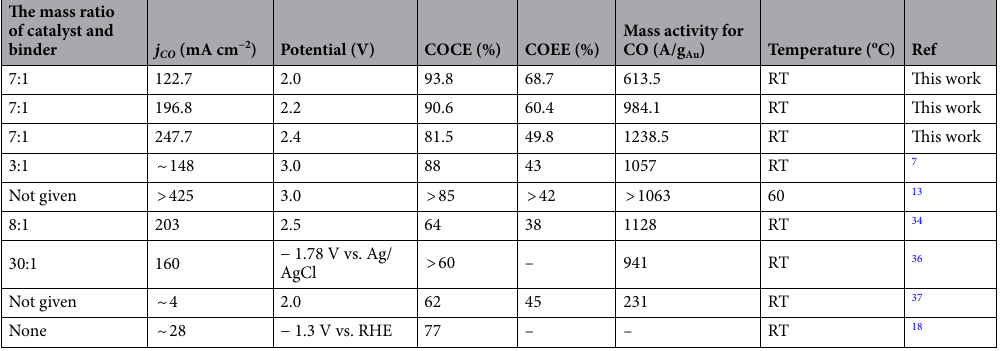
Table 1. Summary of reported CO 2 electrolyzers using Au